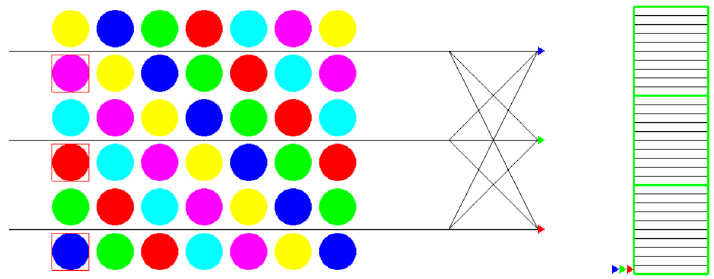
Figure 5. Visualization of port scheduling model.